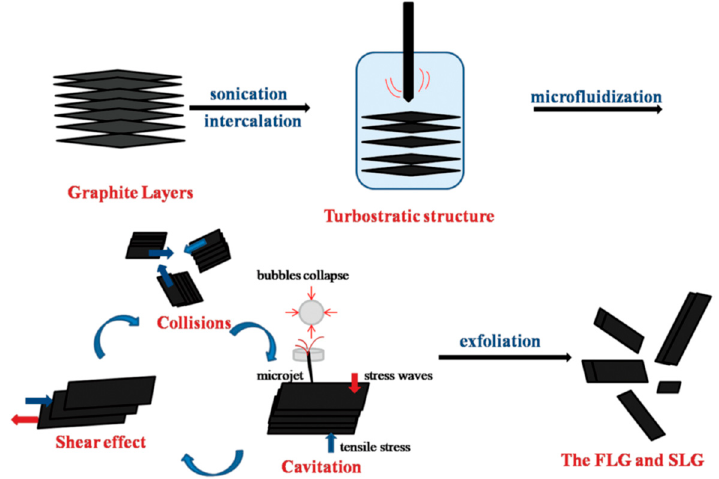
Figure 11. Exfoliation process and mechanism. Reproduced from [60]. Copyright American Scientific Publishers, 2017.